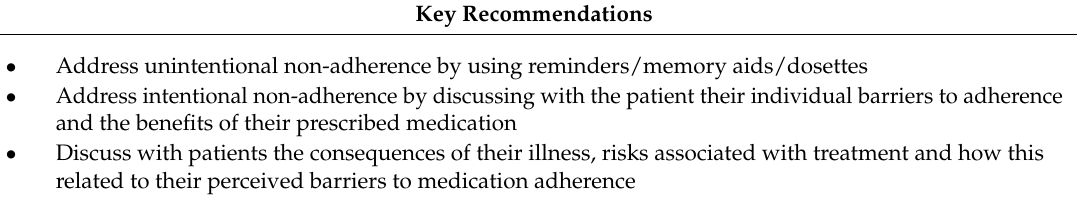
Table 1. Key recommendations regarding beliefs about